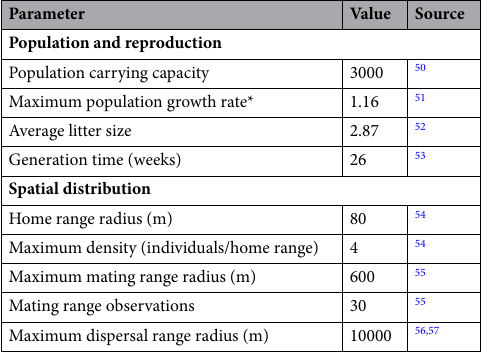
Table 1. Key parameters used in the model for the grey squirrel. For the rest of the parameters, see the supplementary code. *Calculated as the log ( max { R 0 } )